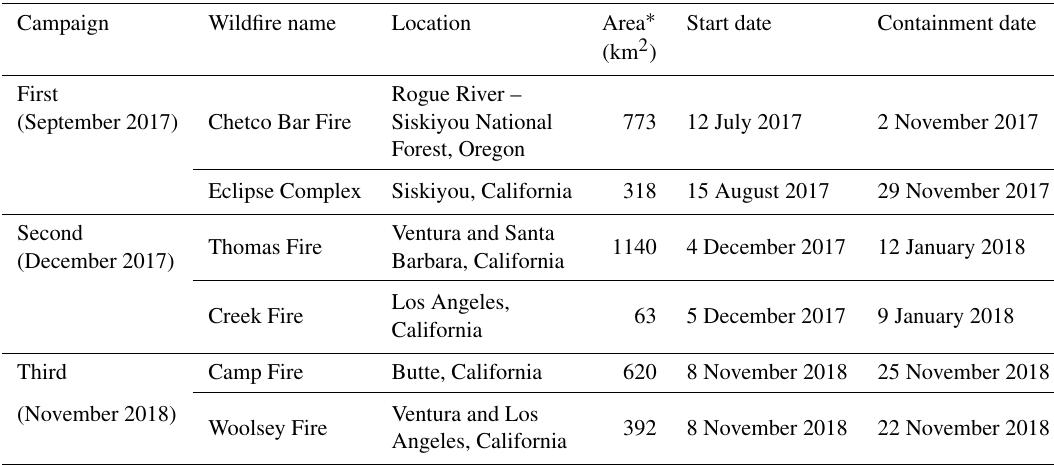
Table 1. Major wildfires that were active during the three campaigns. Only the two largest fires from each campaign (in terms of burn area) are listed in the table below. Note that there were numerous other smaller fires that were active during the three campaigns, but they are not listed in this